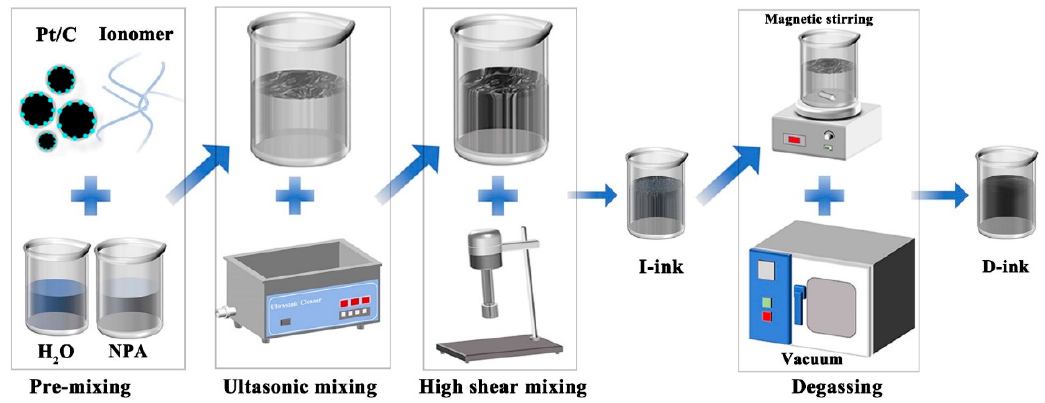
Figure 1. Schematic representation of the process of HSC ink preparation. Table 1. Sample composition of catalyst inks.